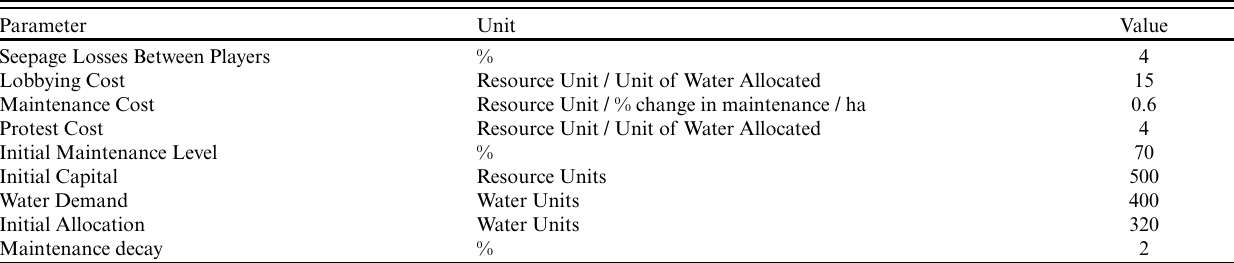
Table 1 . Game parameters.